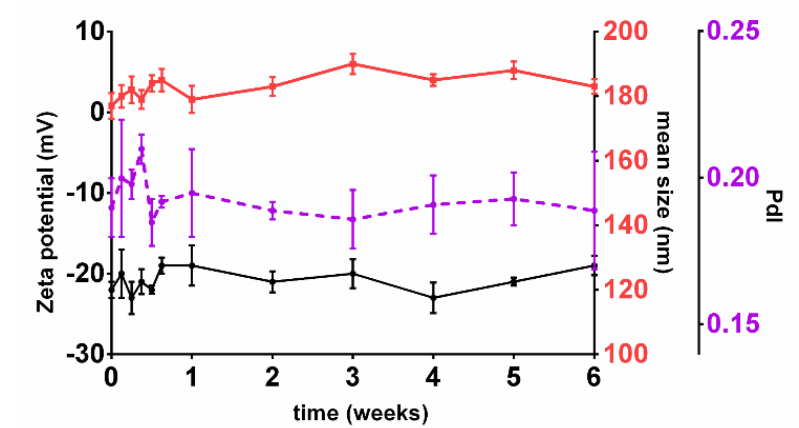
Figure 7. Stability of the prepared checkpoint nanoformulations. Black line: Graphical representation of variations in zeta potential values over 6 weeks (data plotted on the left Y-axis); Red line: Graphical representation of variations in mean sizes over 6 weeks (data plotted on the first right Y-axis); Purple line: Graphical representation of variations in PdI values over 6 weeks (data plotted on the second right Y-axis). Results are given as mean ± SD ( n = 3 ).